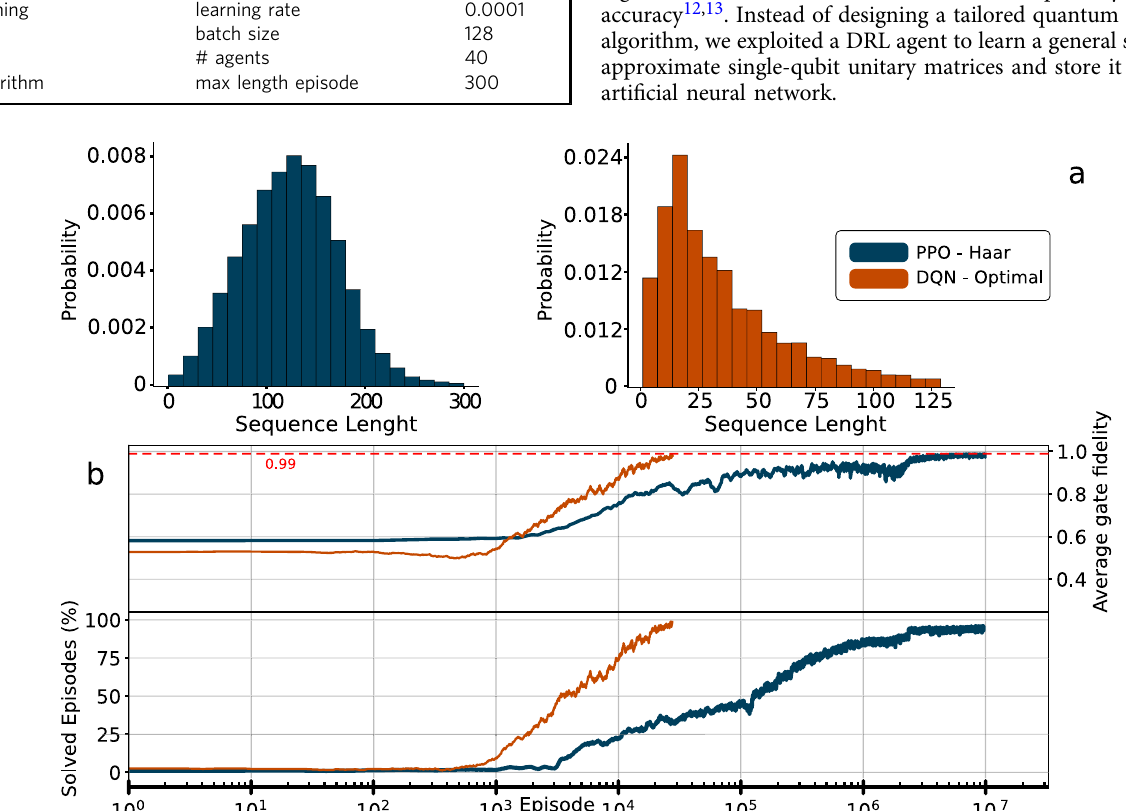
Fig. 3 Deep reinforcement learning agents learn how to approximate single-qubit unitaries using different base of gates. A proximal policy- optimization agent (PPO) (blue color) and a deep Q-learning hindsight-experience replay agent DQL + HER (orange color) were trained to approximate single-qubit unitaries using two different bases of gates, i.e., six small rotations of π /128 around the three-axis of the Bloch sphere and the Harrow – Recht – Chuang ef fi cient base of gates (HRC), respectively. The tolerance was fi xed to 0.99 average gate fi delity. a The length distributions of the gates sequences discovered by the agents at the end of the learning. The HRC base generates shorter circuits as expected. b Performance of the agent during training on the tasks.